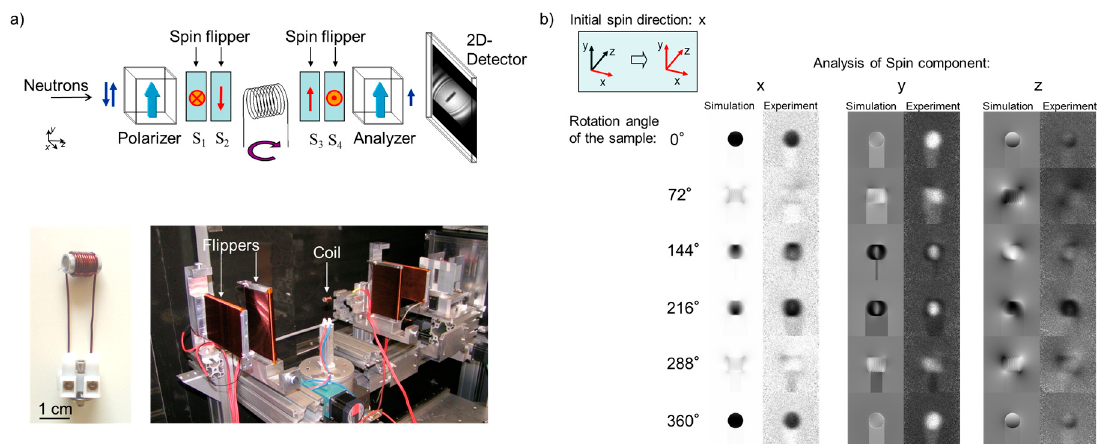
Figure 5. ( a ) Polarimetric arrangement for quantitative imaging with polarized neutrons; ( b ) Measured and simulated spin precession images for different rotation angles of a solenoid for initial spin direction x and analysis of the three orthogonal components of the spin precession angle.